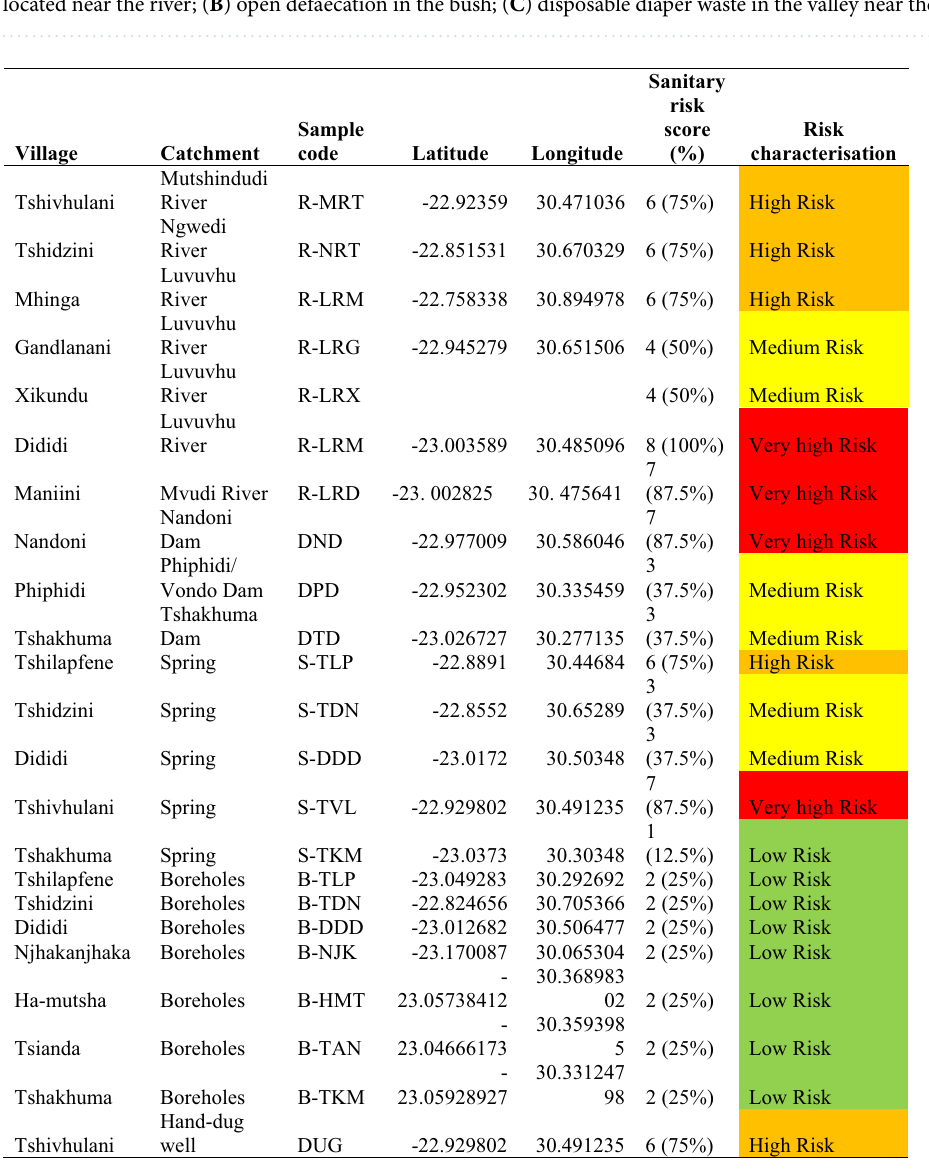
Table 4. Percentage sanitary risk score and risk rating at various catchment areas located in villages in the Vhembe District